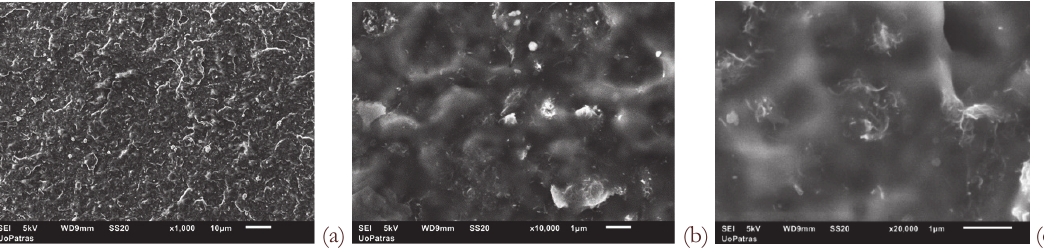
Figure 4: SEM photos of an area in the MWCNT/PP 5 wt%_01 specimen: a. x1,000, b. x10,000 and c. x20,000.